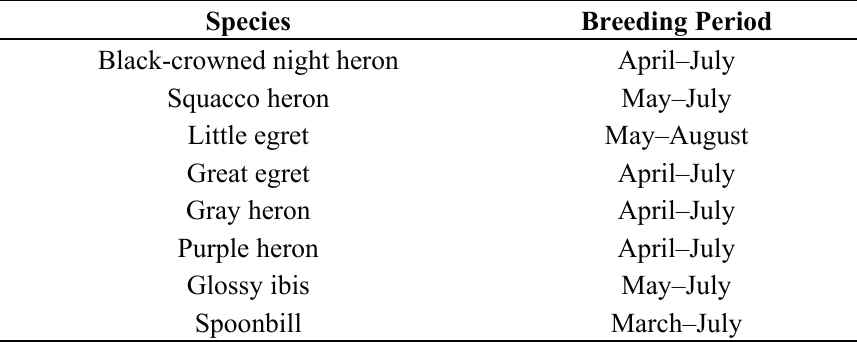
Table 3. Breeding periods of herons and ibises in Central